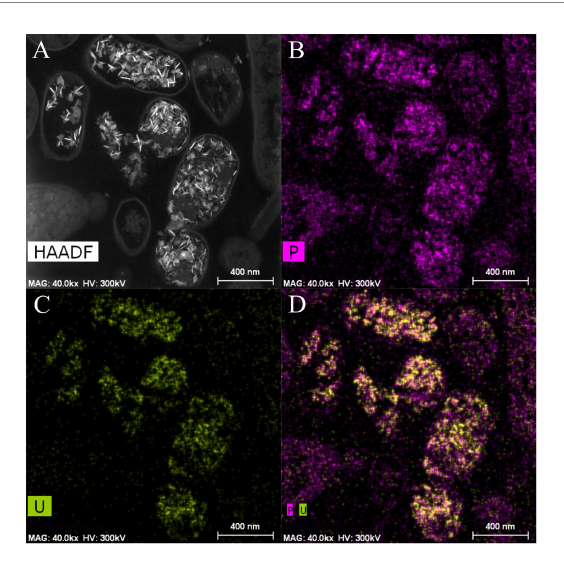
FIGURE 4 High angle annular dark-field-scanning transmission electron microscopy (HAADF-STEM) image of Microbacterium sp. Be9 cells after incubation under MC1 condition (A) ; EDX element mapping for P (B) , U (C) and P–U combined (D)